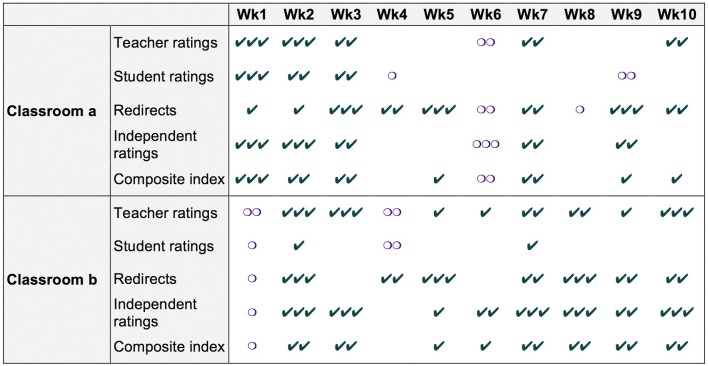
Differences in classroom engagement after lessons in nature for different classrooms, weeks, and measures. Condition differences in classroom engagement are depicted with symbols. The color and shape denotes the condition which yielded better classroom engagement, for a particular measure, classroom, and week; when the lesson in nature outperformed its paired classroom lesson, there are green checkmark(s); when the lesson in the classroom outperformed its paired nature lesson, there are purple circle(s). The number of symbols (checkmark or circle) represents the extent to which one condition outperformed the other, with one symbol corresponding to a difference between half a standard deviation and a full standard deviation (>0.5 to ≤1), two symbols corresponding to a difference between one and two standard deviations (>1 to ≤2), and three symbols corresponding to a difference of over two standard deviations. When the difference between a lesson in nature vs. the classroom did not exceed half a standard deviation, no symbols are depicted.